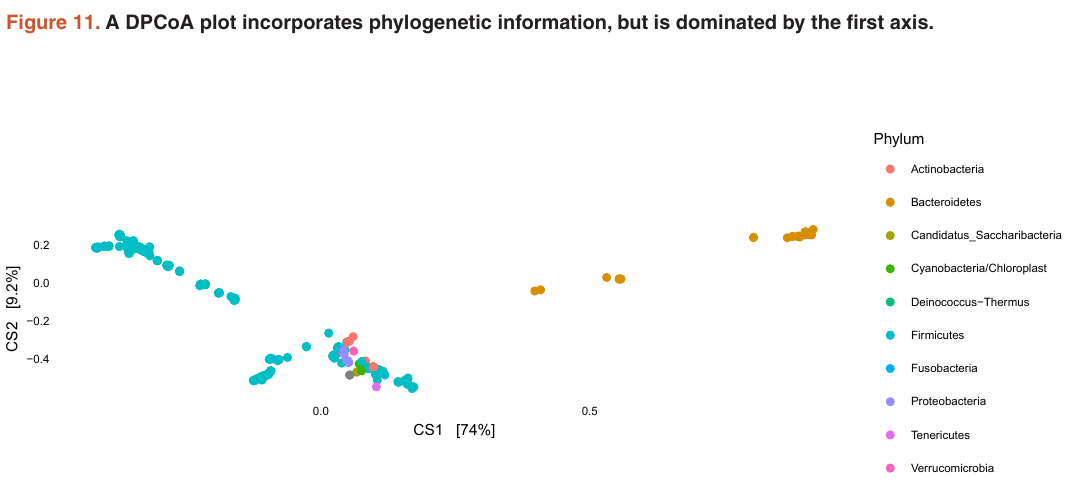
Figure 12. The DPCoA sample positions can be interpreted with respect to the species coordinates in this display.